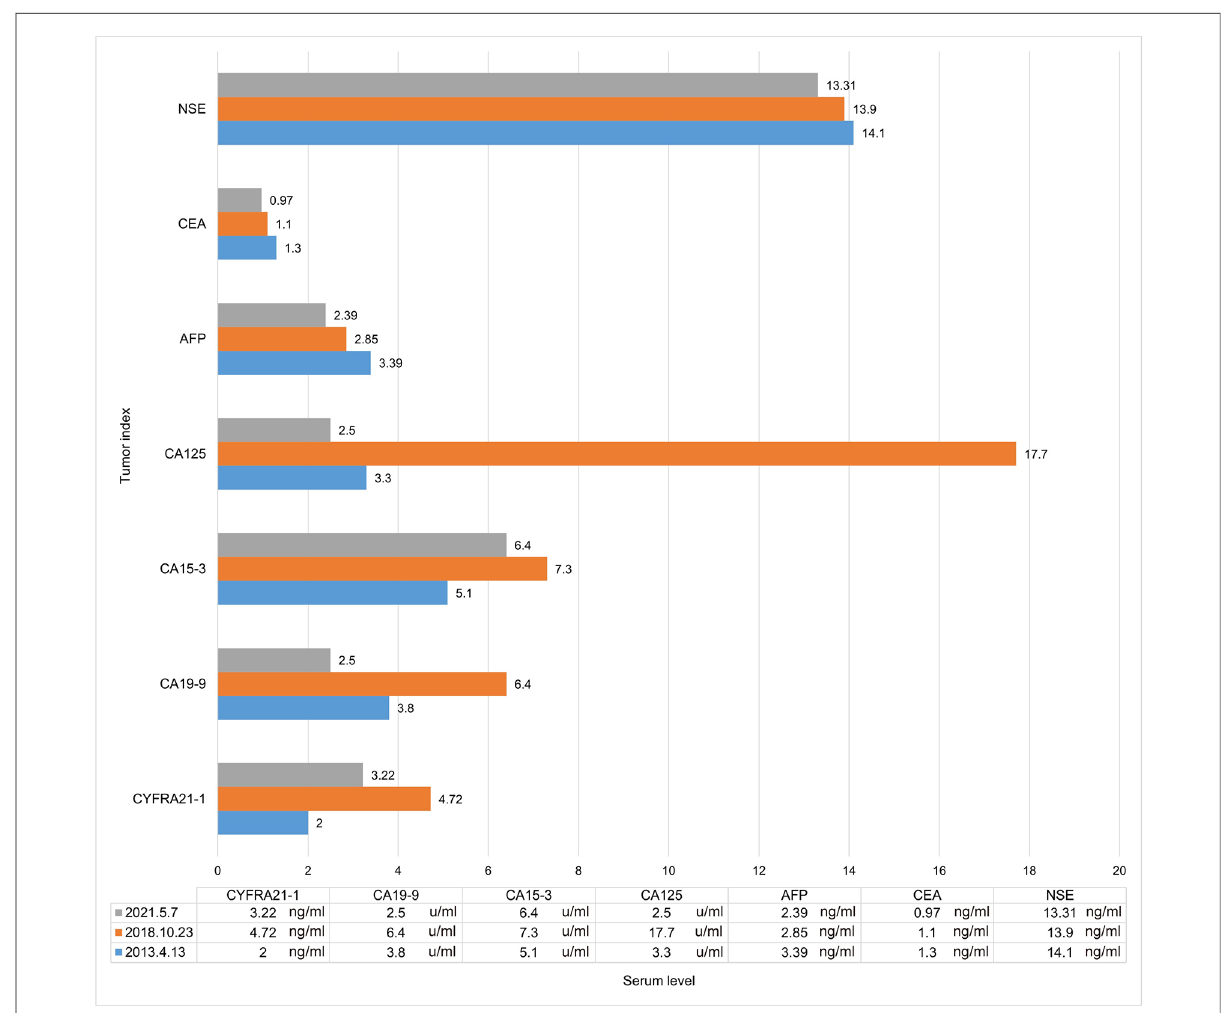
FIGURE 2 Tumor indicator levels when discovering lesions. AFP, alpha fetoprotein; CEA, carcinoembryonic antigen; NSE, neuron-speci fi c enolase; CYFRA21-1, cytokeratin 19 fragment; CA125, carbohydrate antigen 125; CA19-9, carbohydrate antigen 19-9; CA15-3, carbohydrate antigen